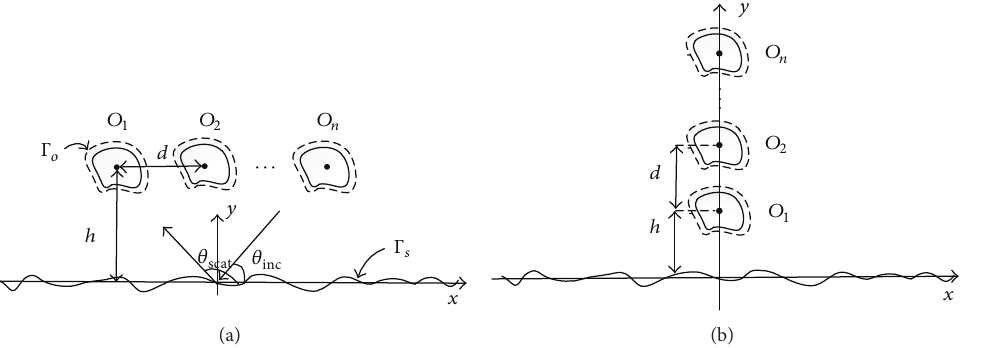
Figure 2: Schematic of the scattering from multiple dielectric objects over the PM sea surface: (a) arranged along the horizontal direction; (b) arranged along the vertical direction.